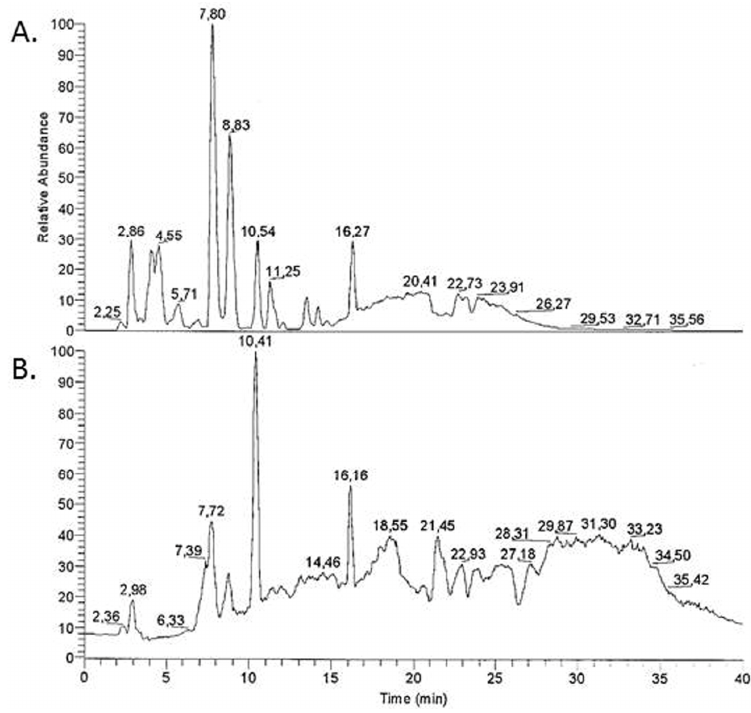
Table 1. Antibodies used for expression analysis of steroid hormone receptors.